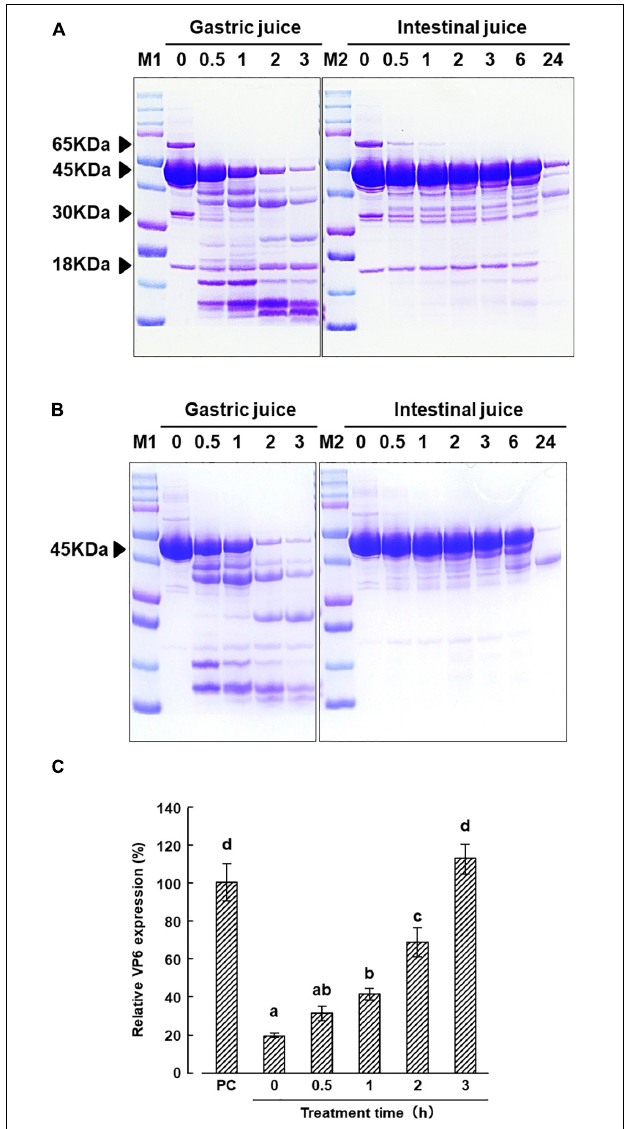
FIGURE 5 | Effect of digestive juice treatment on KT-11 LE and KT-11 SLP. SDS-PAGE patterns of (A) KT-11 LE and fractionated LE, (B) KT-11 SLP after treatment with simulated gastric juice (1.6% pepsin in 0.1 M KCl/HCl, pH 2.0) and intestinal juice (0.1% pancreatin in PBS, pH 7.2) for the indicated time periods. Lane 1 (M1) and lane 7 (M2): molecular weight marker, lanes 2–6: digestion pattern by gastric juice for the indicated time periods (h), lanes 8–14: digestion pattern by intestinal juice for the indicated time periods (h). (C) Inhibitory effect on DS-1 infection in pre-infection treatment with KT-11 SLP digested with gastric juice for the indicated times periods. The results are shown as means with standard deviations relative to KT-11 SLP-untreated viral-infected control ( n = 3). PC represents the condition of viral-infected and KT-11 SLP-untreated condition. Different letters denote a significant difference at p <